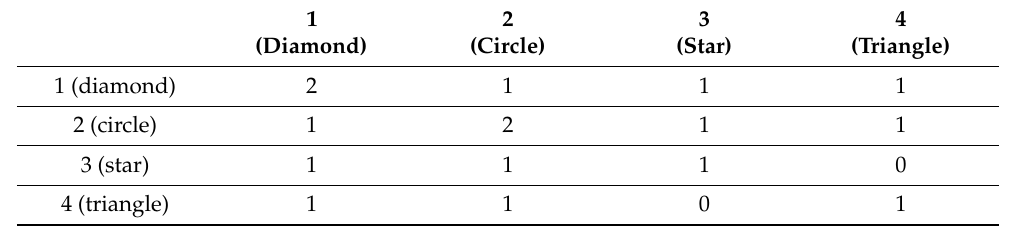
Figure 1. Primary – secondary relation between paper and its references. In conventional co-citation based on paper research disciplines the Cartesian relation between all research disciplines of a paper would be accounted for (upper dashed rectangle). Likewise, in conventional co-citation based on references the Cartesian relation between all referenced research disciplines would be considered (lower dashed rectangle). In this work, solely the Cartesian product between paper research disci- plines and referenced research disciplines is considered. Figure 2. An arbitrary paper assigned to research disciplines 1 (Square) and 2 (Circle). It is assumed that integration of knowledge takes place between the research disciplines of the paper and those of the references, 1 (Square) ,3 (Star) and 2 (Circle) ,4 (Triangle), respectively. In common co-citation profiles the relation of references 1 (Square) and 2 (Circle) as common references of paper 1 are accounted for (line marked with X). However, there is no similarity between reference 1 (Square) and 2 (Circle), if it was not for the citing paper. Their relationship fails to satisfy the prerequisite of integration. Thus there is no increment for the relation of 3 (star) to 4 (triangle) in the corresponding frequency matrix (Table 1). On the main diagonal, the absolute occurrence of a research discipline is denoted. Table 1. Corresponding frequency matrix for Figure 2.